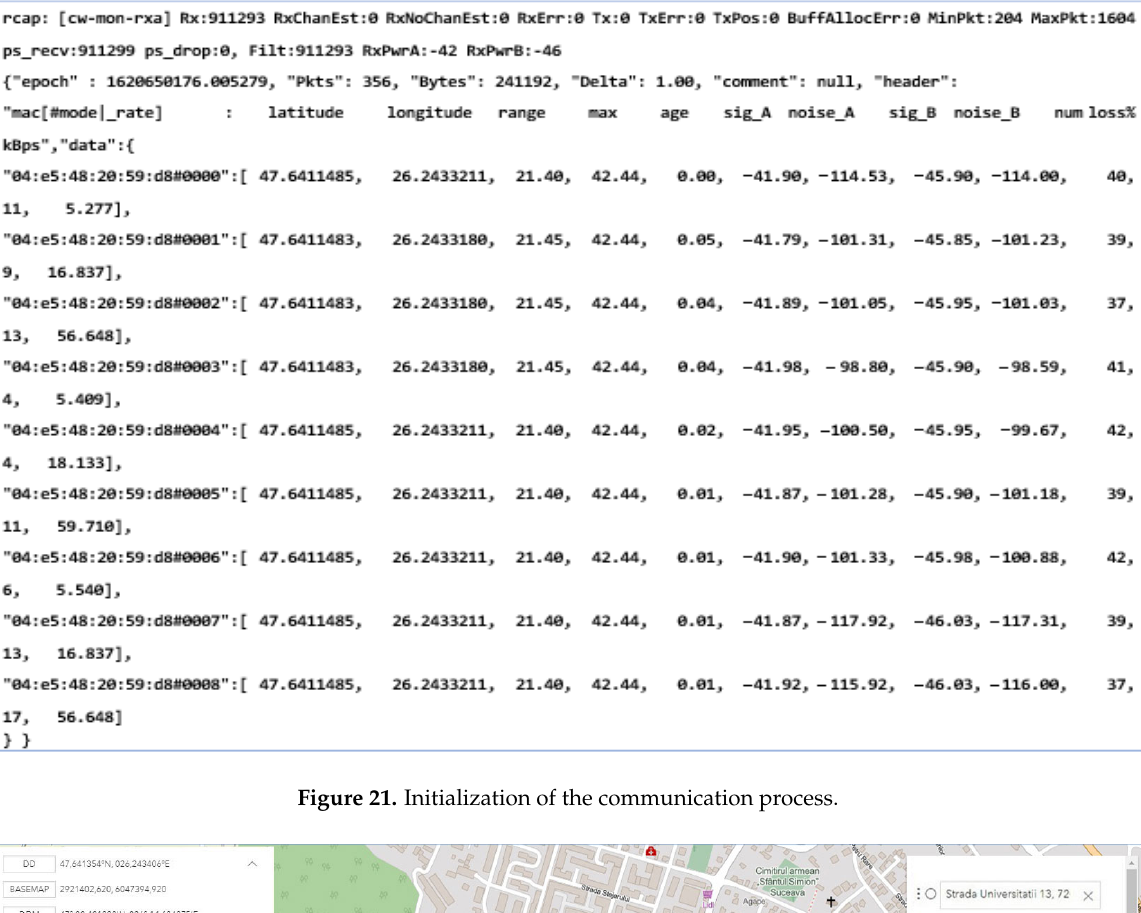
20 of 39 Figure 20. GPS and IP/MAC communication and activation procedure.